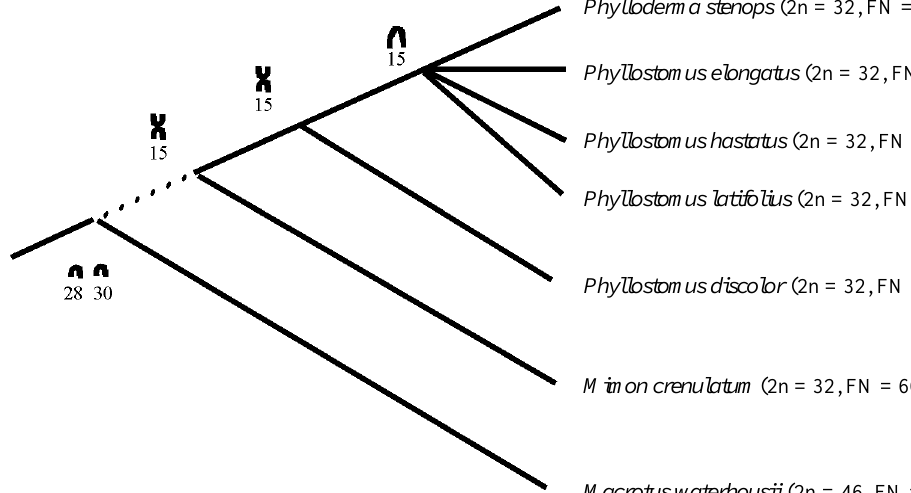
Figure 4 - Chromosomal phylogeny of the genus Phyllostomus based on literature